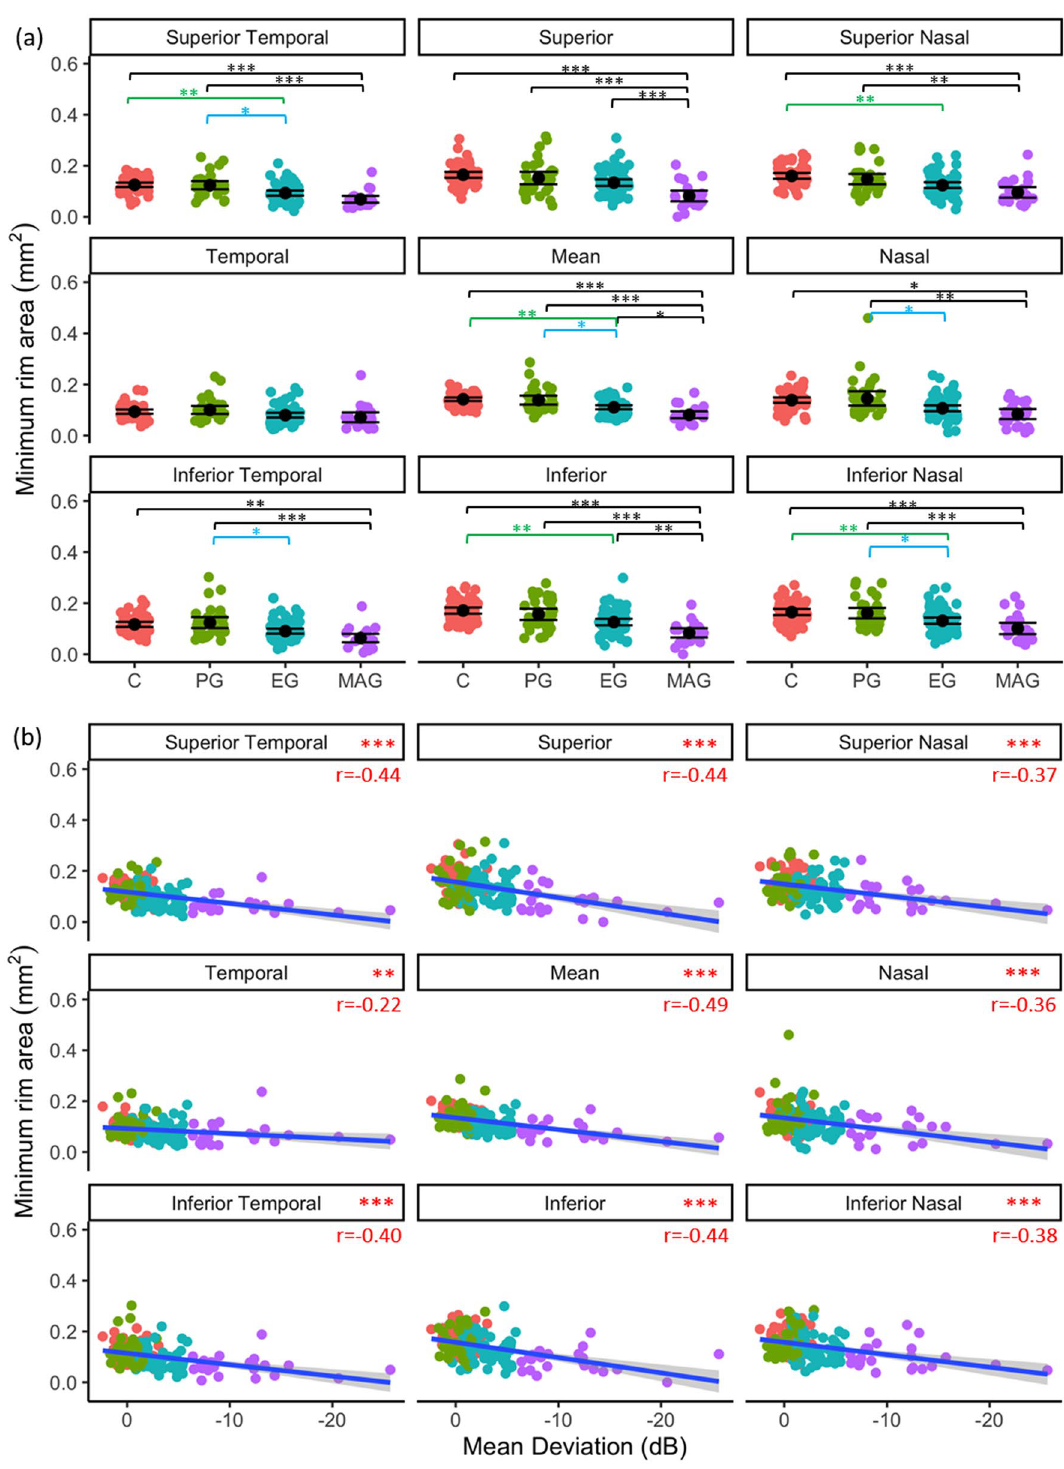
Figure 5. Regional MRA as a function of glaucoma disease stage ( a ); black point represents mean and error bars indicate 95% confidence intervals, and ( b ) visual field status (VF MD). Blue line represents regression line and grey shading indicates 95% confidence intervals. Red text indicates significant Pearson’s correlation (r) values at p < 0.05. * p < 0.05, ** p < 0.01, *** p <